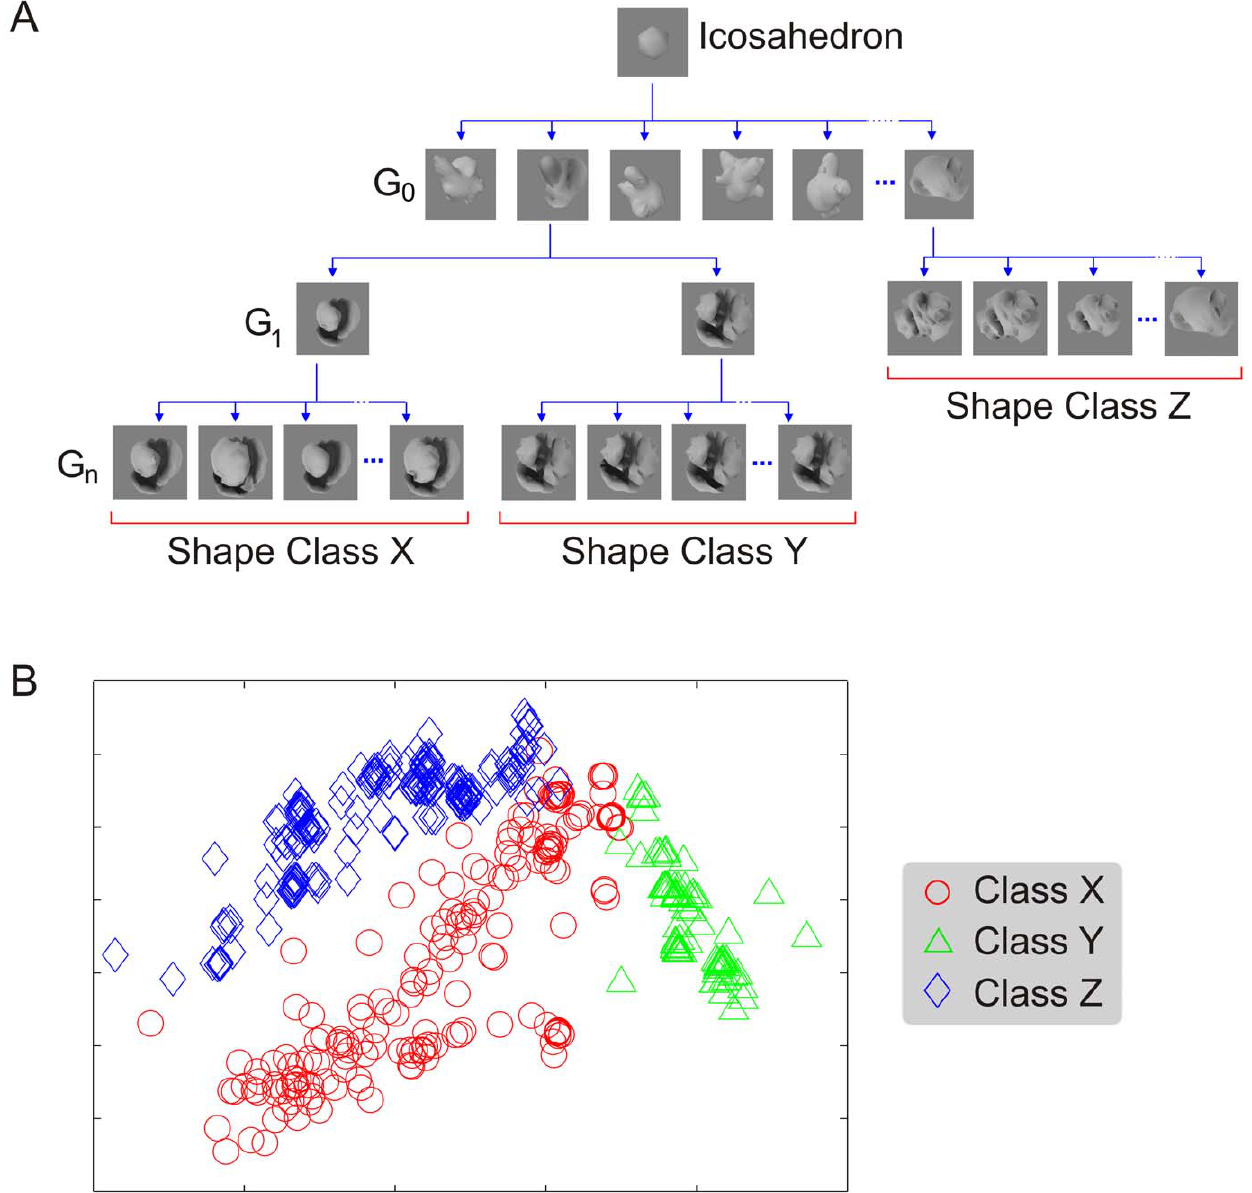
Figure 1. Naturalistic shape classes generated by virtual phylogenesis (VP). ( A ) The VP algorithm for generating naturalistic shape classes. This algorithm simulates biological evolution, in that shape characteristics evolve as random heritable variations are differentially propagated through successive generations [12,13]. Note that the differences between, as well as within, the categories arise spontaneously and randomly during VP, rather than as a result of externally imposed rules, including the fragment selection process or any other classification scheme. The bottom of the evolutionary cascade denotes the three shape classes used in many of the experiments in this study. See refs. [12,13] for additional examples of shape classes. ( B ) Shape variations within and across classes X, Y and Z as visualized by a metric multi-dimensional scaling (MDS) plot. Each data point represents one object from a given class (inset). MDS plots the data points so as to cluster similar data points together and disperse dissimilar data points from each other, so to provide a principled representation of the relevant classes (for details, see refs. [48,49]).